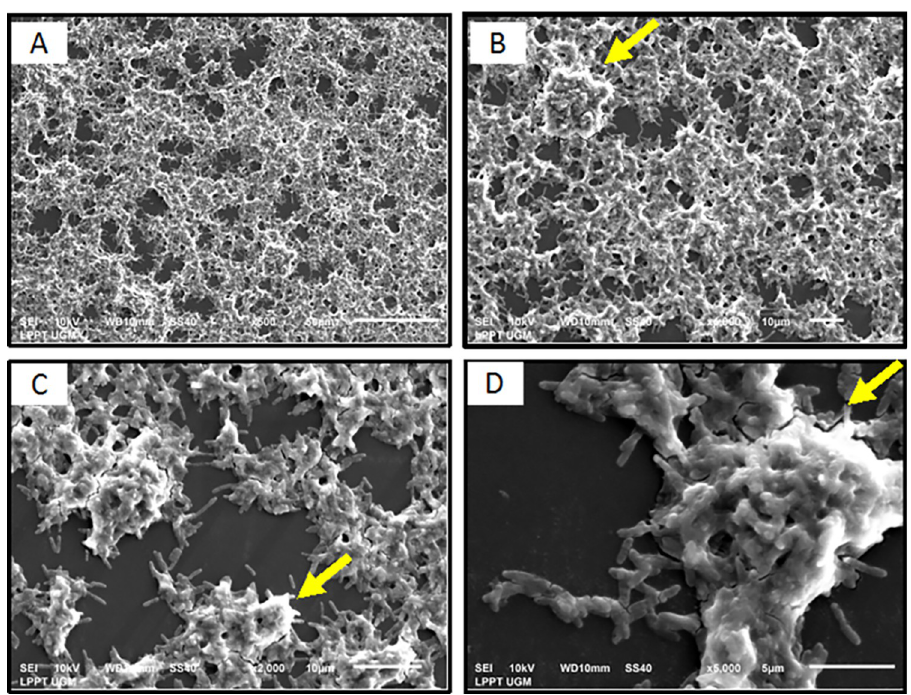
Fig 3. The structure of biofilm cells in the M . fortuitum group on observation by SEM on the 7 th day of incubation. Yellow arrows indicate extra-cellular polymer substance (EPS) formation. (A) Observation at 500 × magnification. (B) Observation at 1000 × magnification. (C) Observation at 2000 × magnification. (D) Observation at 5000 × magnification.